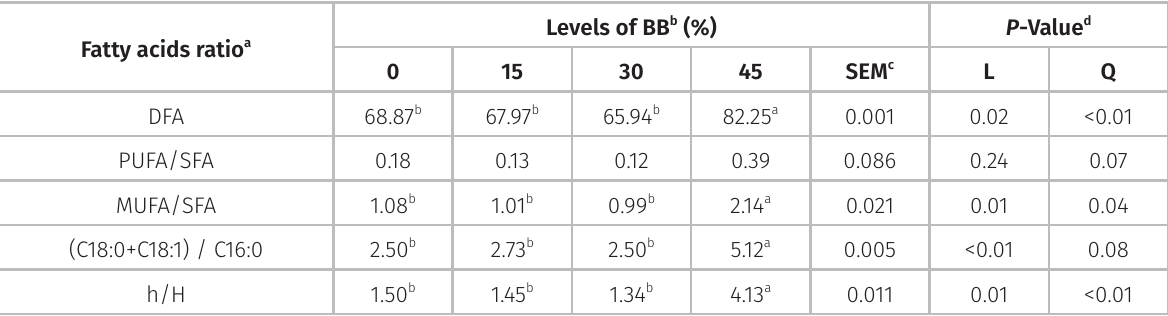
Table VI. Effects and standard errors of health indices of meat in lambs fed with biscuit bran (BB).